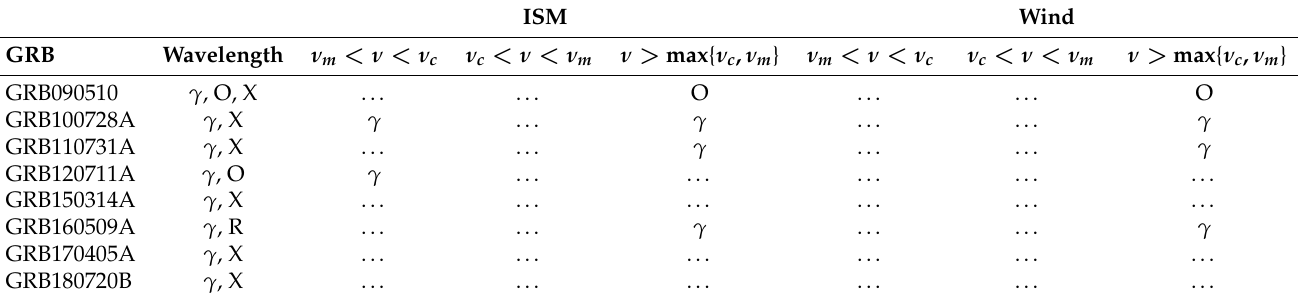
of the GRB in the high-energy sample that has also been analyzed in either X-rays, optical, or radio wavelengths. Column 2 gives the wavelengths for which a particular GRB has been analyzed— γ for γ -rays, X for X-rays, O for optical, and R for radio. Columns 3, 4, and 5 mark whether a GRB satisfies the given CR in the ISM ( k = 0) environment, while columns 6, 7, and 8 mark whether a particular GRB satisfies the given CR in the wind ( k = 2) environment. Columns are marked with X, O, or R to represent whether the relation has been satisfied in X-ray, optical, or radio wavelengths; ‘...’ is placed in all columns for which the GRB does not satisfy the given